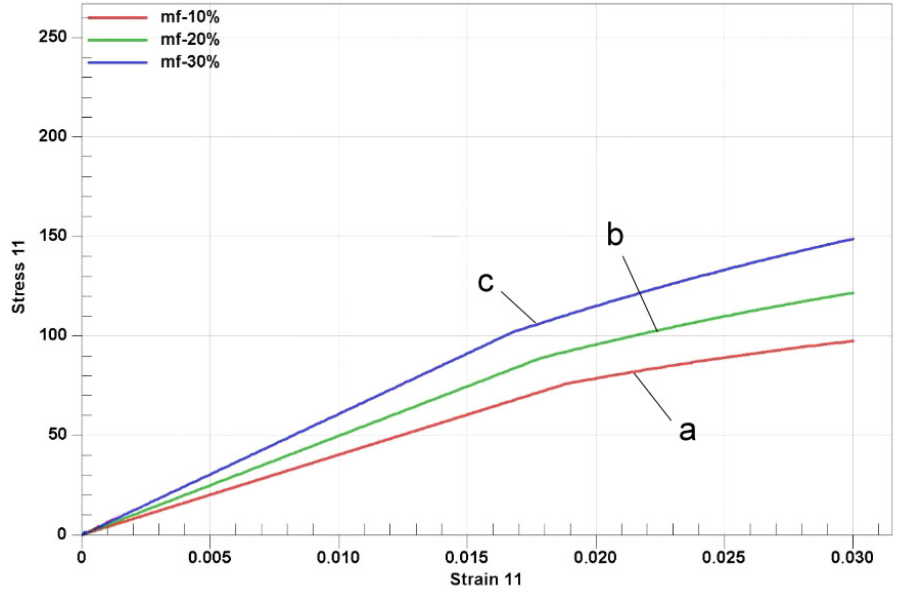
Figure 7. Stress–strain diagrams for a composite material based on a polycarbonate matrix containing: (a) 10% of inclusions (red line), (b) 20% of inclusions (green line), (c) 30% of inclusions (blue line). Table 3. Computed properties of the studied composite (polycarbonate matrix with the content of glass fibers in the